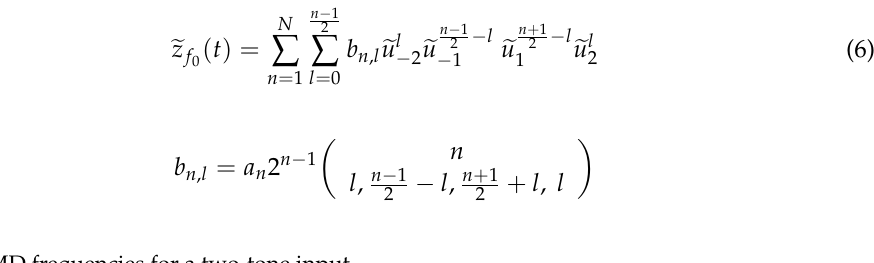
Table 1. IMD frequencies for a two-tone